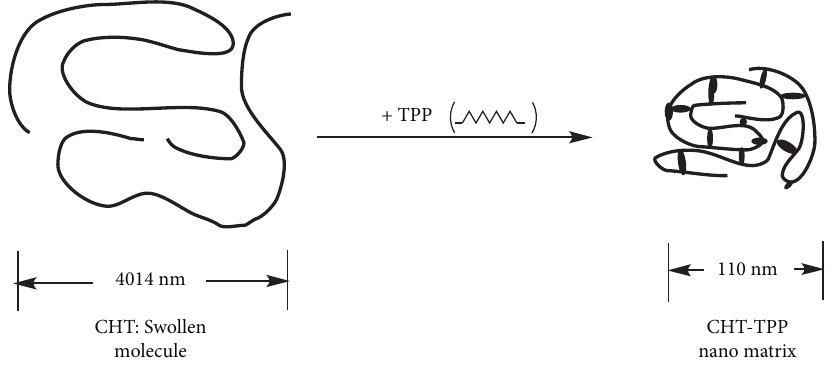
Figure 11: Cross-linking ions of chitosan [3].